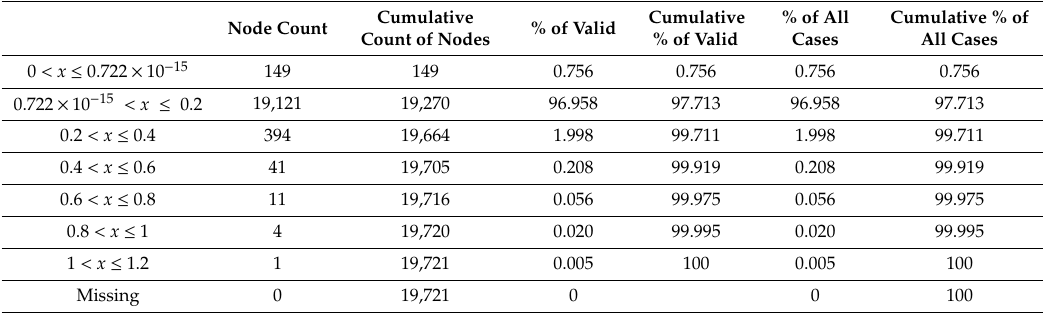
Cumulative % of All Cumulative % of Cumulative % of Valid Node Count % of Valid Cases All Cases Count of Nodes